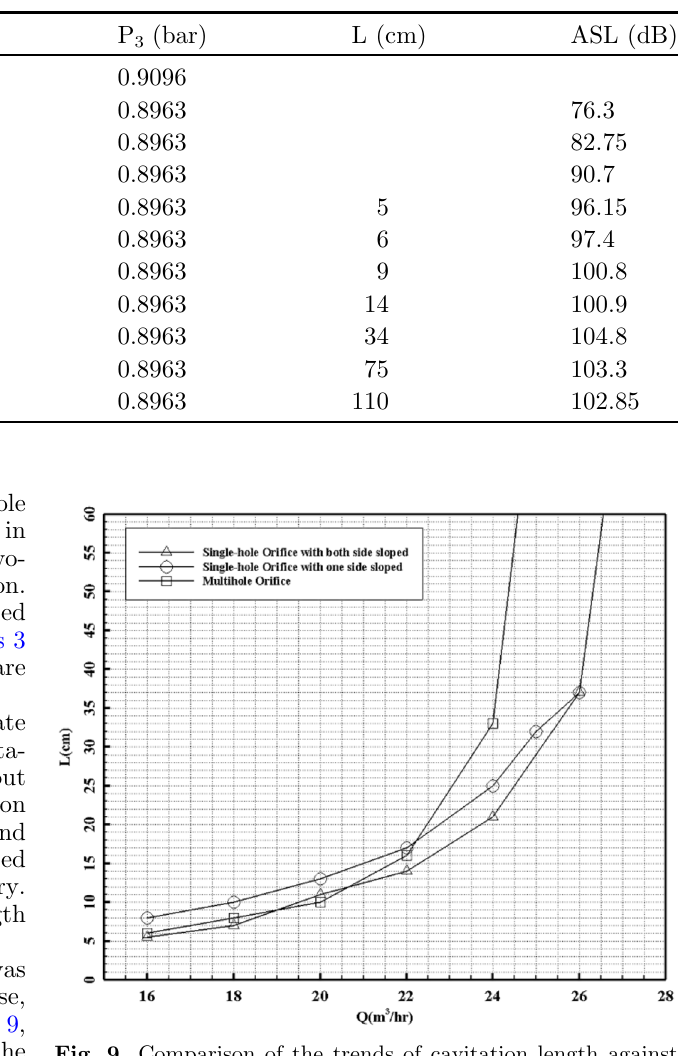
Fig. 9. Comparison of the trends of cavitation length against fl ow in a multi-hole ori fi ce a single ­ -hole ori fi ce with a two-sided sloped edge and a single-hole ori fi ce with a one-sided sloped